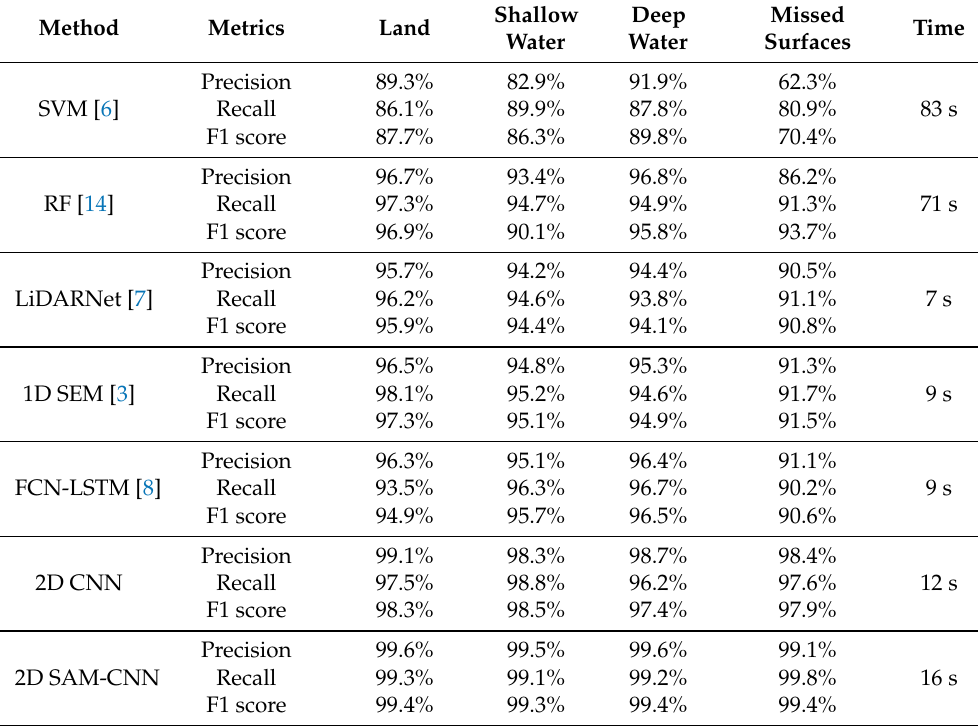
Table 4. Comparison of different methods of bathymetry data